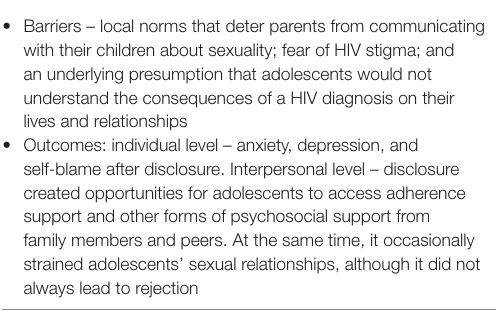
TABLe 2 | High level summary of selected articles. Mburu et al. (23) Barriers and outcomes of Hiv